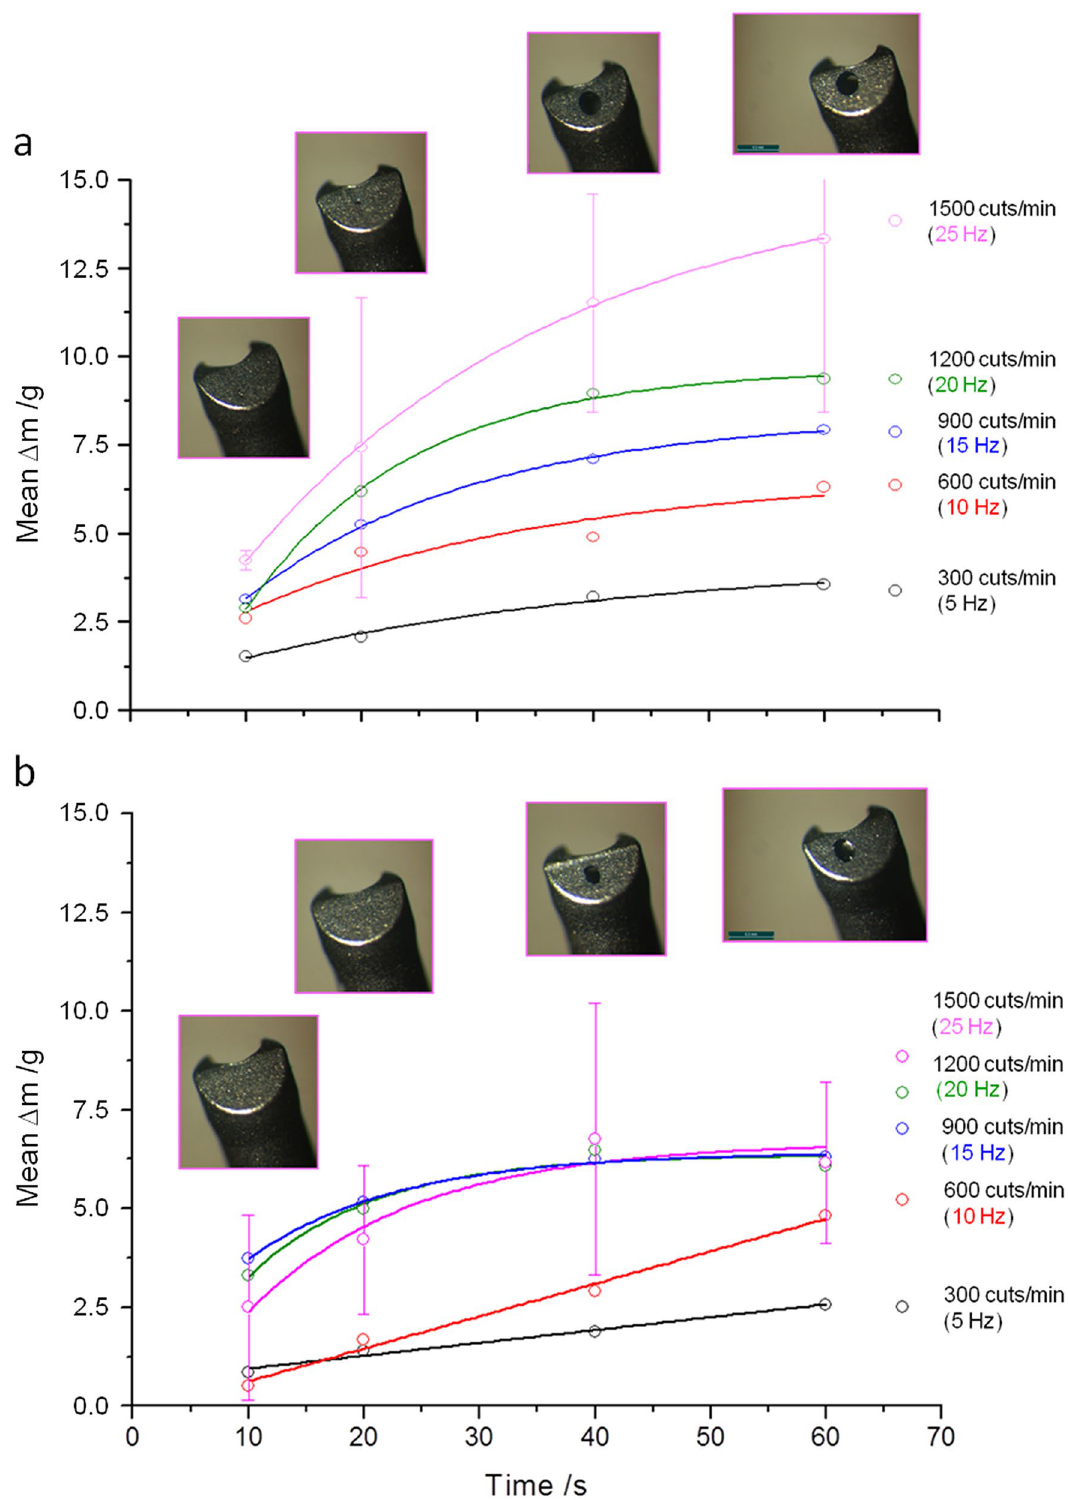
Figure 2. Aspiration rates given for the Mark I handpiece at 4 mJ (2a) and 3 mJ (2b) pulse energy and cut rates of between 300–1500 cuts/min (5–25 Hz). Above the 25 Hz graph are images of the absorber plates located at the distal end of the LaserVit-tips. By exceeding measurement times of ≥ 40 s, absorber plates are abraded by laser